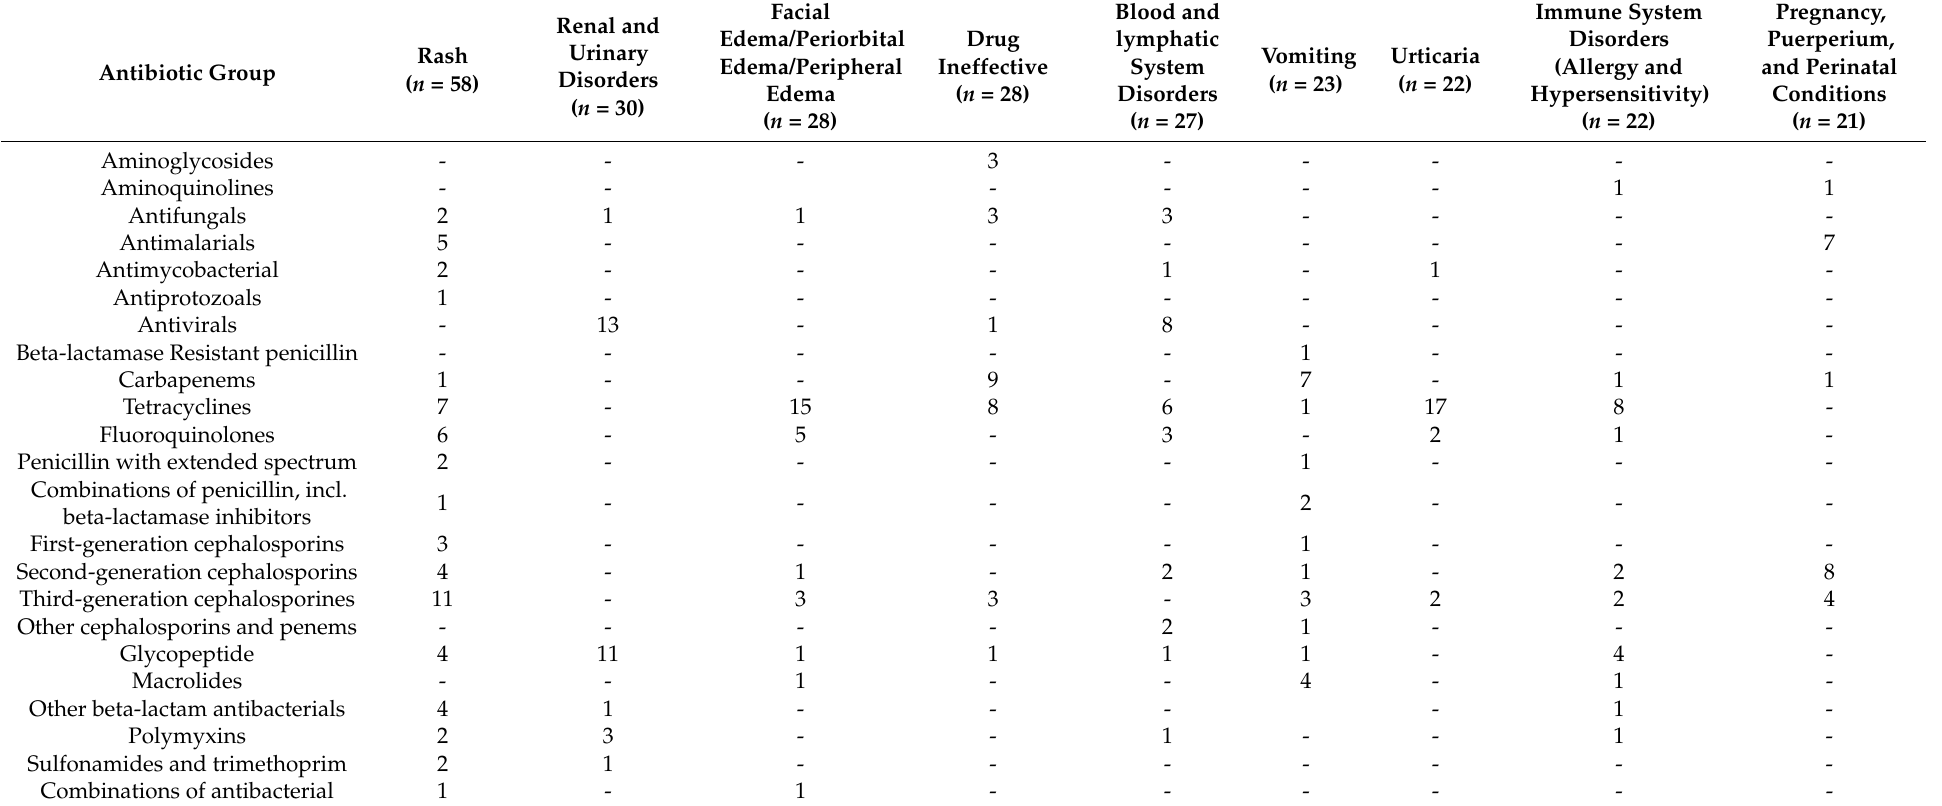
Table 5. The most common antimicrobial-related ADEs and their corresponding antimicrobial.